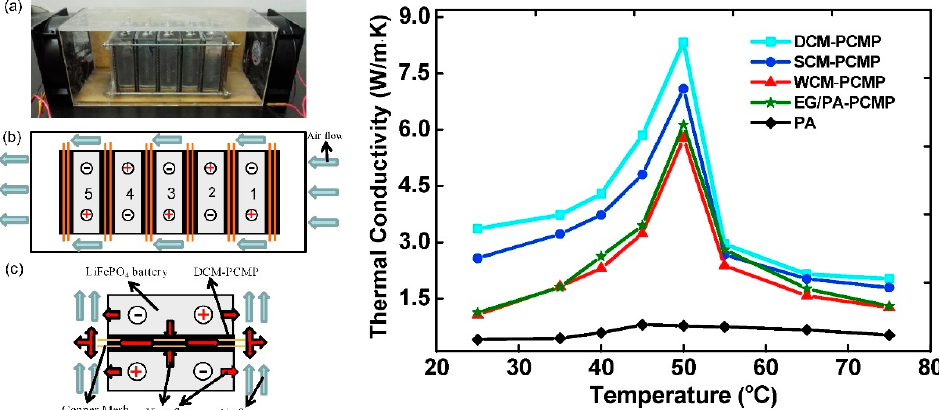
Figure 19. ( a ) Image of the physical set up; ( b ) schematic diagram of the battery system; ( c ) detail view of the copper mesh placement [72] ( left ) and the thermal conductivity of the composite structures ( right ). Reproduced with permission from Elsevier.